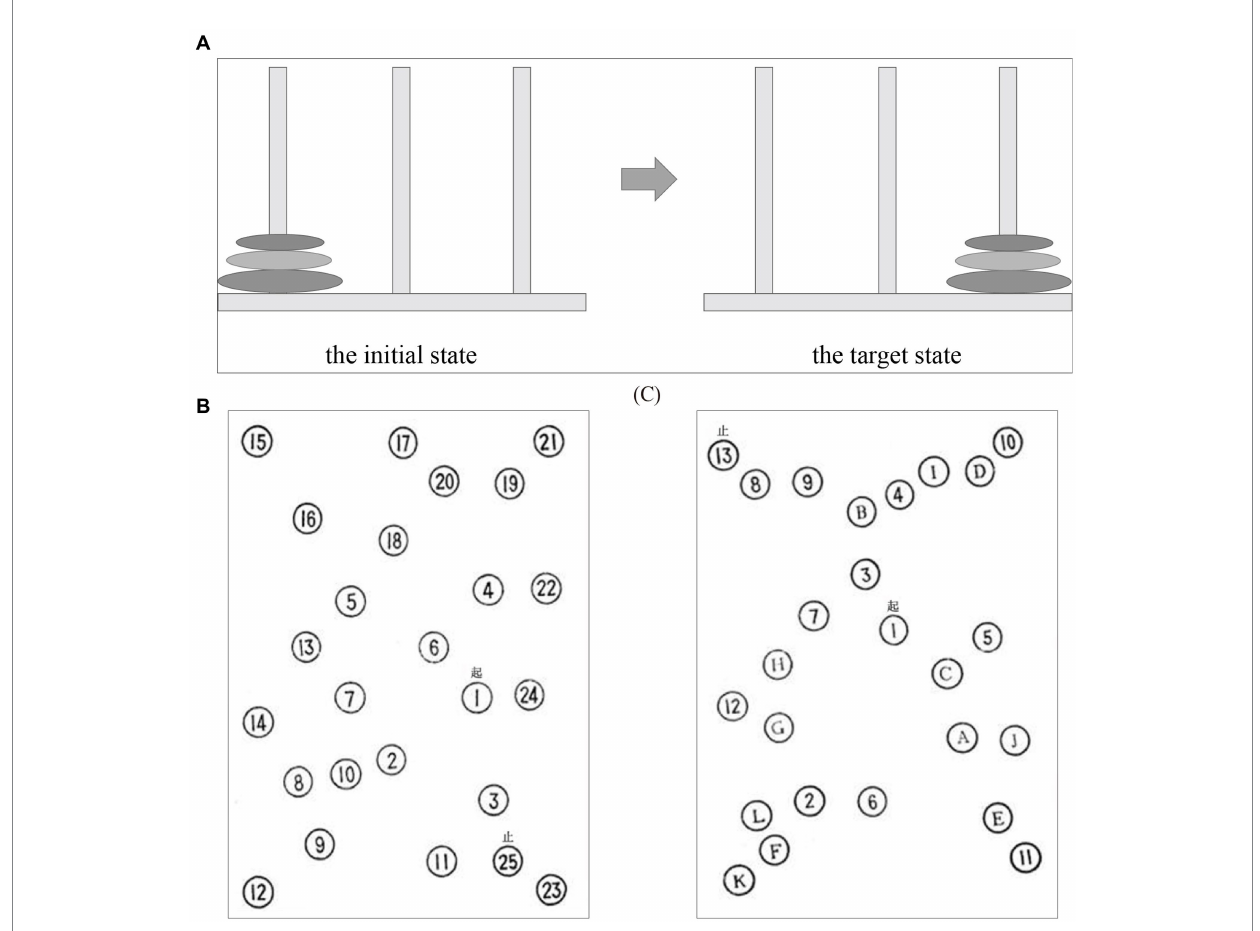
FIGURE 1 The three cool executive tasks: (A) the Tower of Hanoi Task; (B) Trail-Marking Test A; (C) Trail-Marking Test